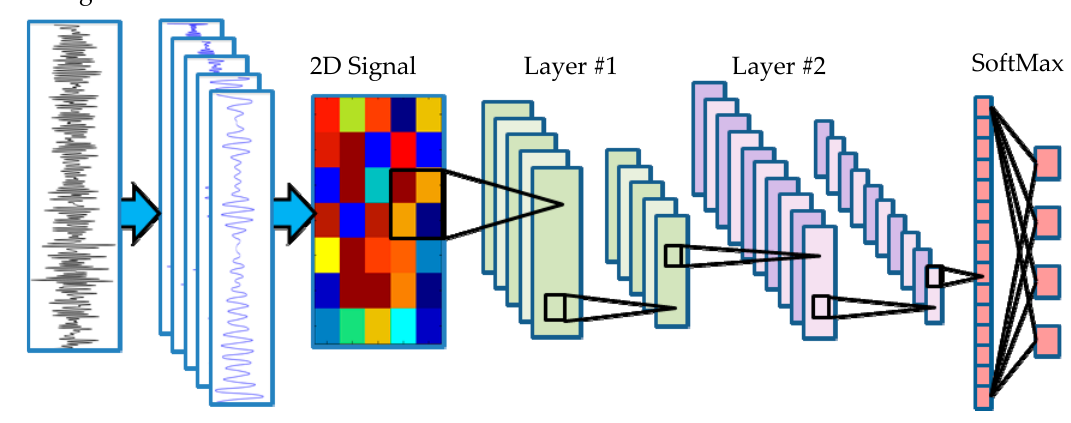
Figure 2. Schematic of the propose method in this paper. DTCWT, dual tree complex wavelet transform.